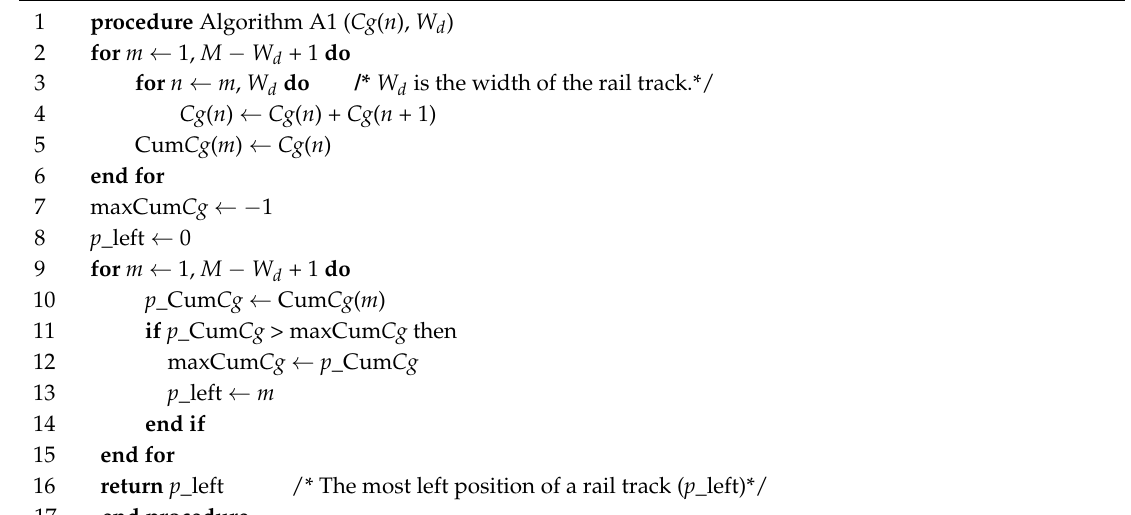
Algorithm A1. The Algorithm A1 for track extraction. procedure Algorithm A1 ( Cg ( n ), W d )